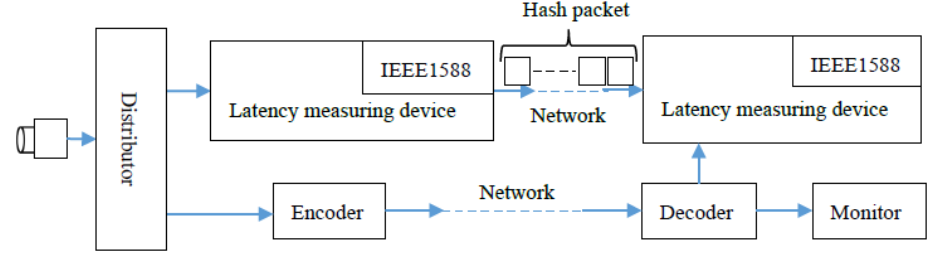
Figure 5. Lossless remote video online measurement scheme.